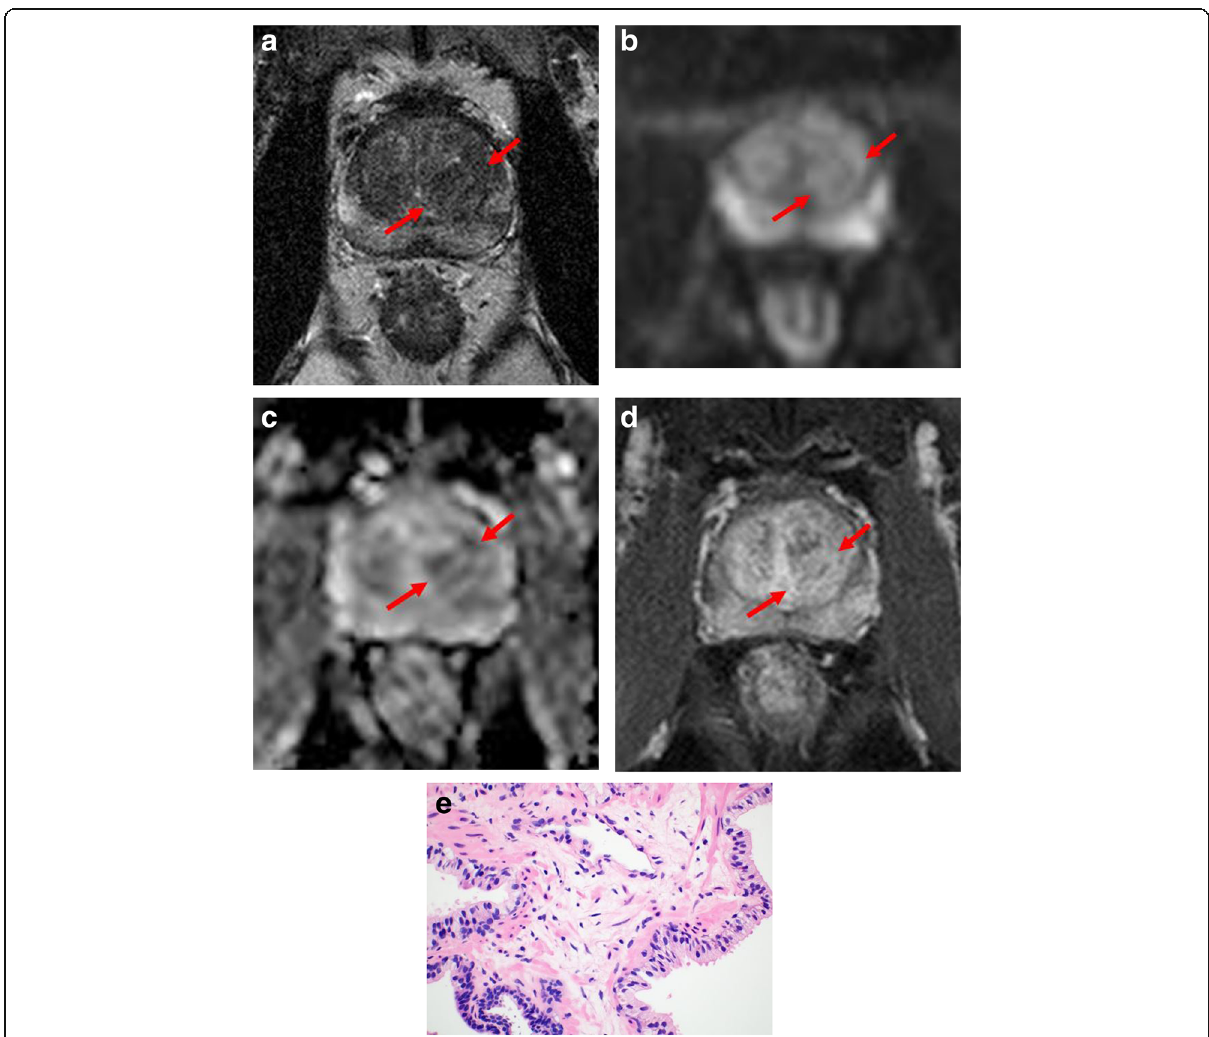
Fig. 4 Multiparametric magnetic resonance image of a 61-year-old man with a left transition-zone nodule (serum prostate-specific antigen 5.318 ng/ml, apparent diffusion coefficient [ADC] 0.868). An axial T2-weighted image (T2WI) ( a ) and dynamic contrast-enhanced image ( b ) indicate an approximately 1 cm, heterogeneous, obscured, marginated nodule with minimal enhancement in the left transition zone (arrows), resulting in a T2WI score of 3. Diffusion-weighted imaging (DWI) ( b = 1000) ( c ) demonstrated subtle iso-signal intensity at the corresponding nodule with low signal intensity on an ADC map ( d ), resulting in a DWI score of 3. This lesion was categorized as 3 according to PI-RADS v2.1 but as 3A according to PI-RADS v2.1-B. Transrectal ultrasound-guided prostate biopsy was performed. Pathology confirmed a benign hyperplastic nodule, composed of hyperplastic glands with papillary infoldings and lined by double-layered inner columnar and outer cuboidal epithelium ( e